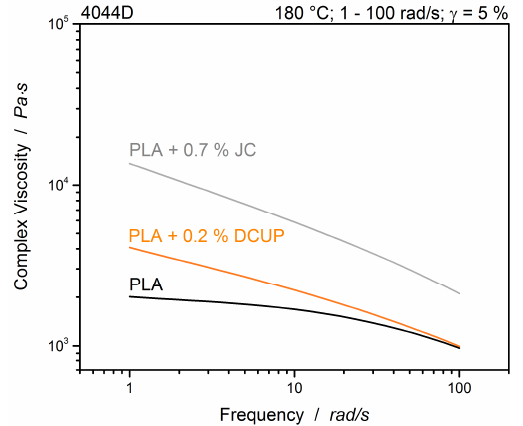
Figure 3. Frequency sweeps of modified and unmodified PLA .